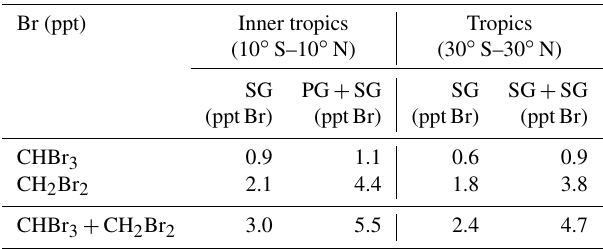
Table 2. Modelled contribution of CHBr 3 and CH 2 Br 2 to the strato- spheric halogen loading in the form of source gas (SG) and total (SG + PG) contribution for